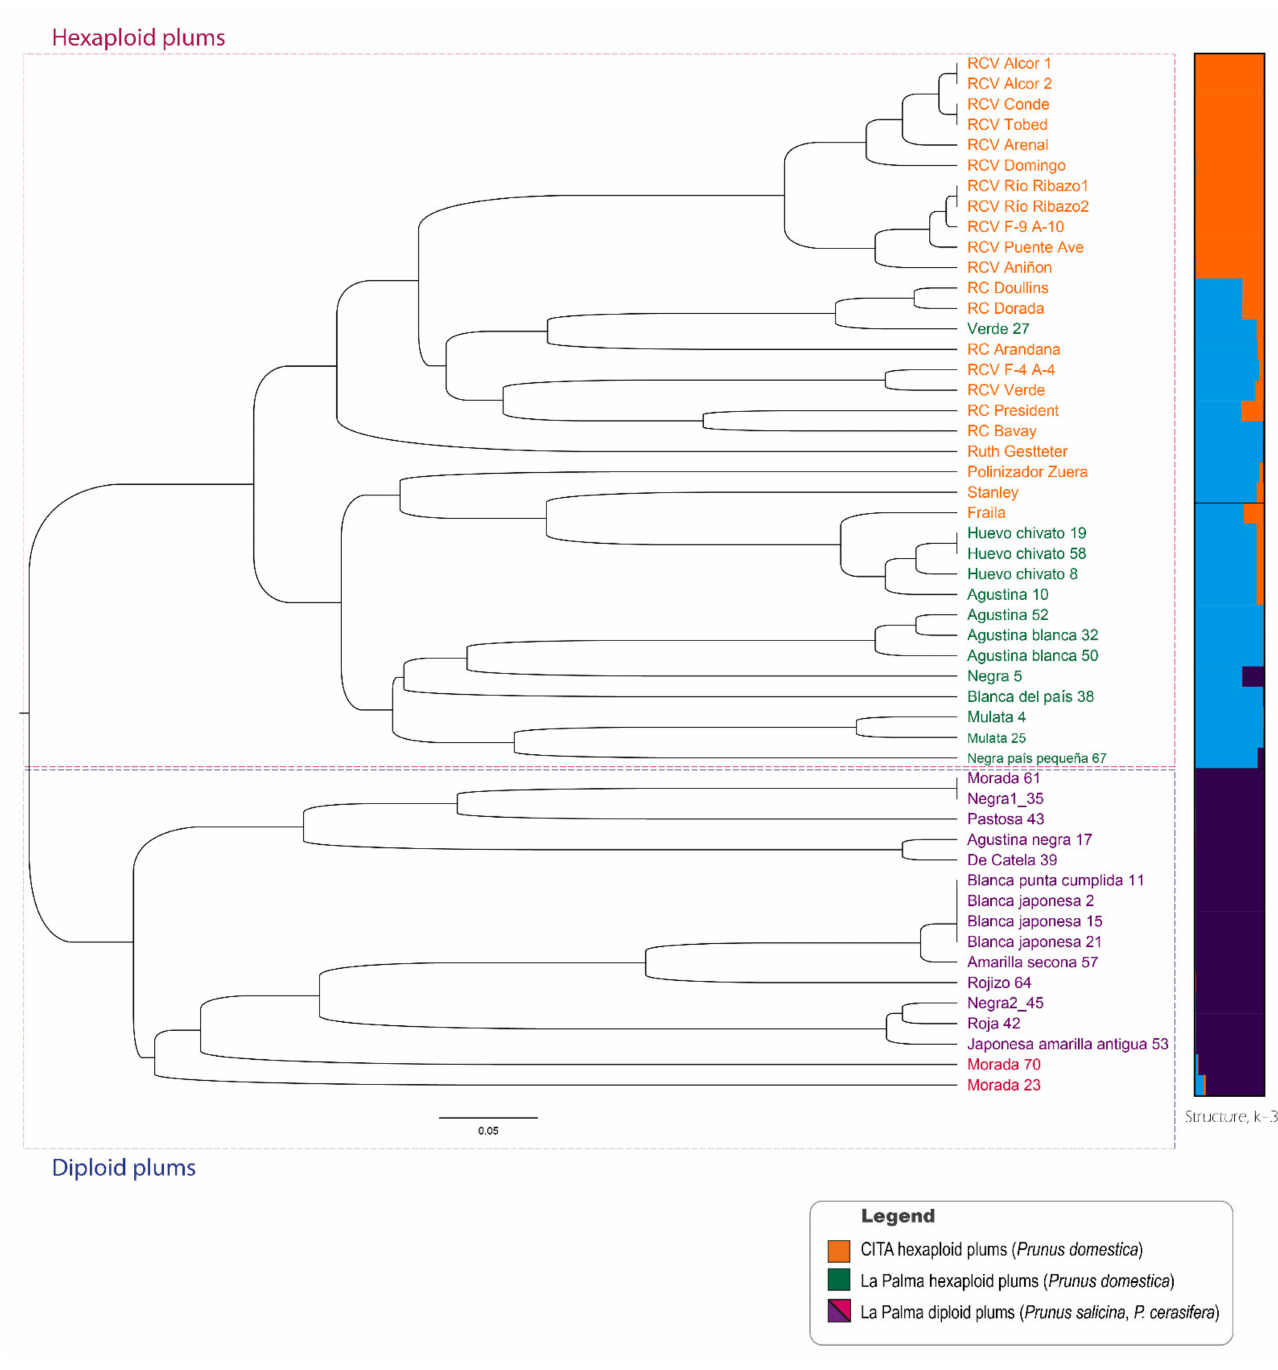
Figure 3. Bruvo-UPGMA cluster analysis based on nine SSR loci in plum species. Groups are indicated with colors: CITA hexaploid plums ( Prunus domestica ) in orange, La Palma hexaploid plums ( P. domestica ) in green and La Palma diploid plums ( P. salicina and P. cerasifera ) in purple and red, respectively. On the right, STRUCTURE results for K = 3 are